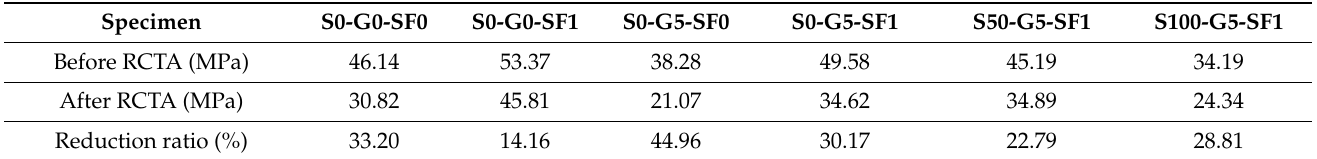
Table 10. Results of